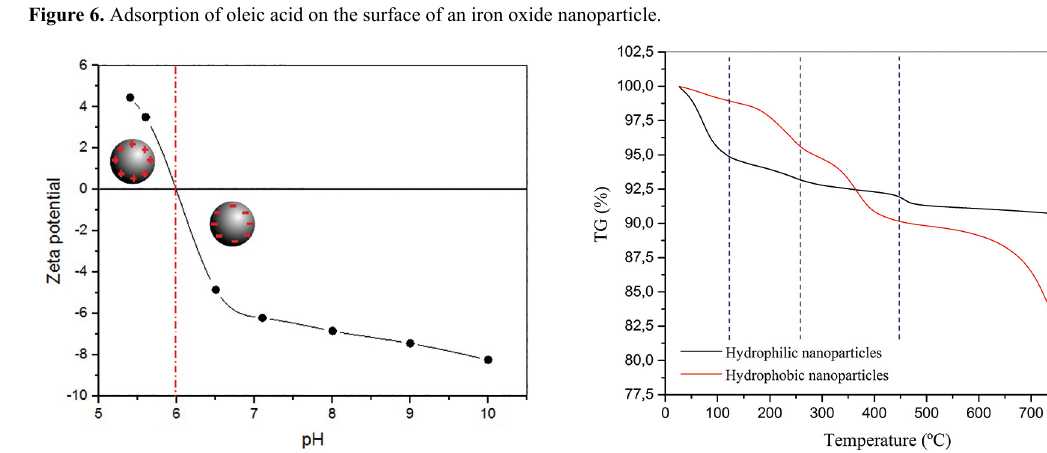
) of the hydrophilic nanoparticles. pzc